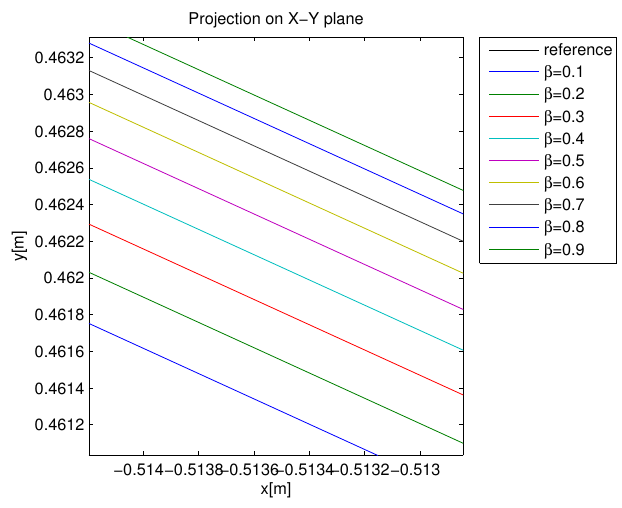
Figure 10. Zoom of the projection in the x-y plane of the trajectory.